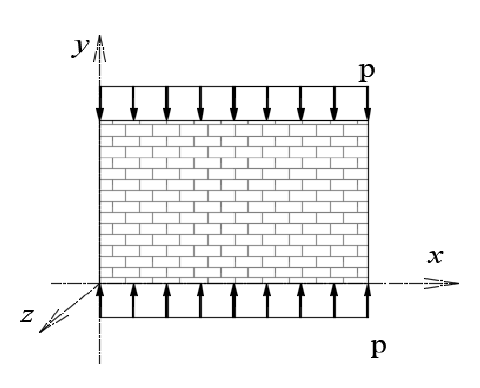
Fig. 2 . The masonry fragment.